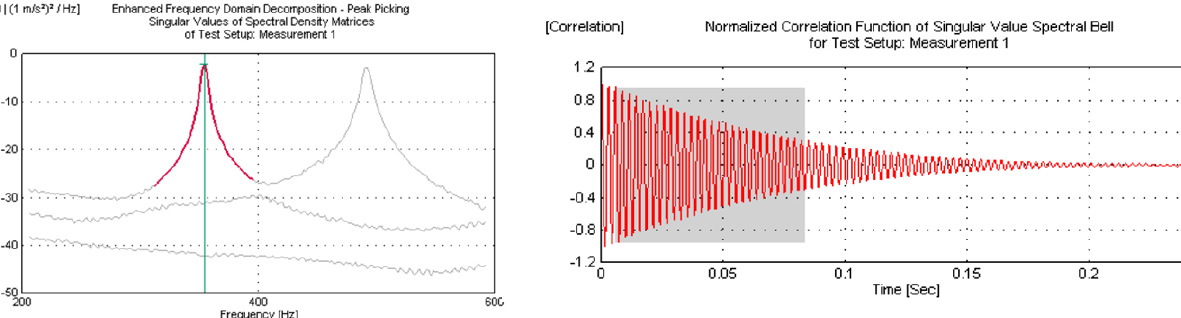
Figure 7. Peak-picking and FDD in the frequency domain (left) and the resultant correlation function from the IFT in the time domain (right) (Jacobsen et al.,